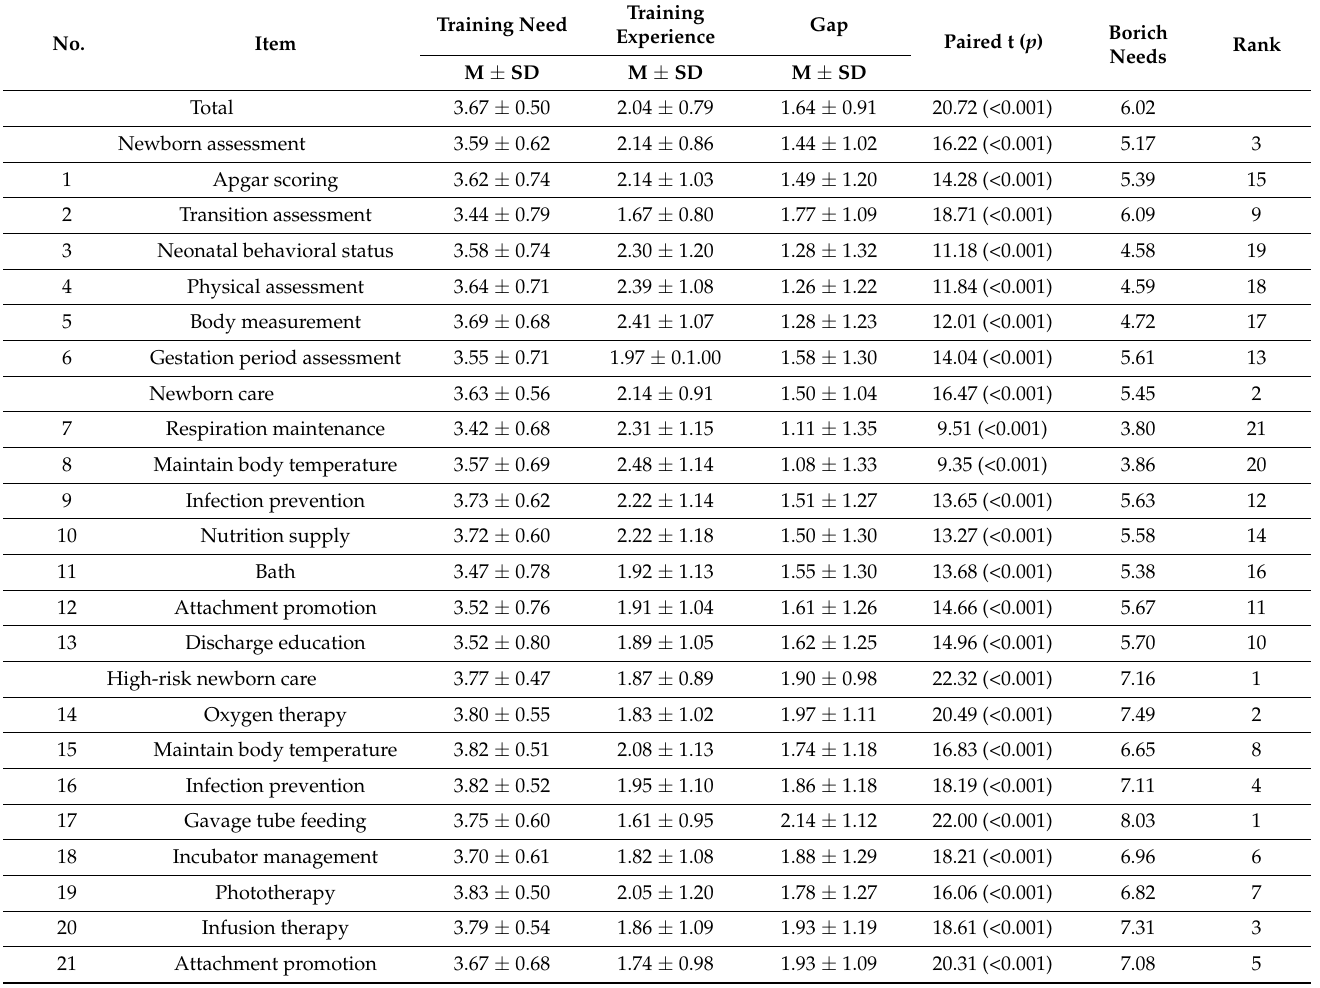
Table 3. Difference between newborn intensive care training need and experience ( n =